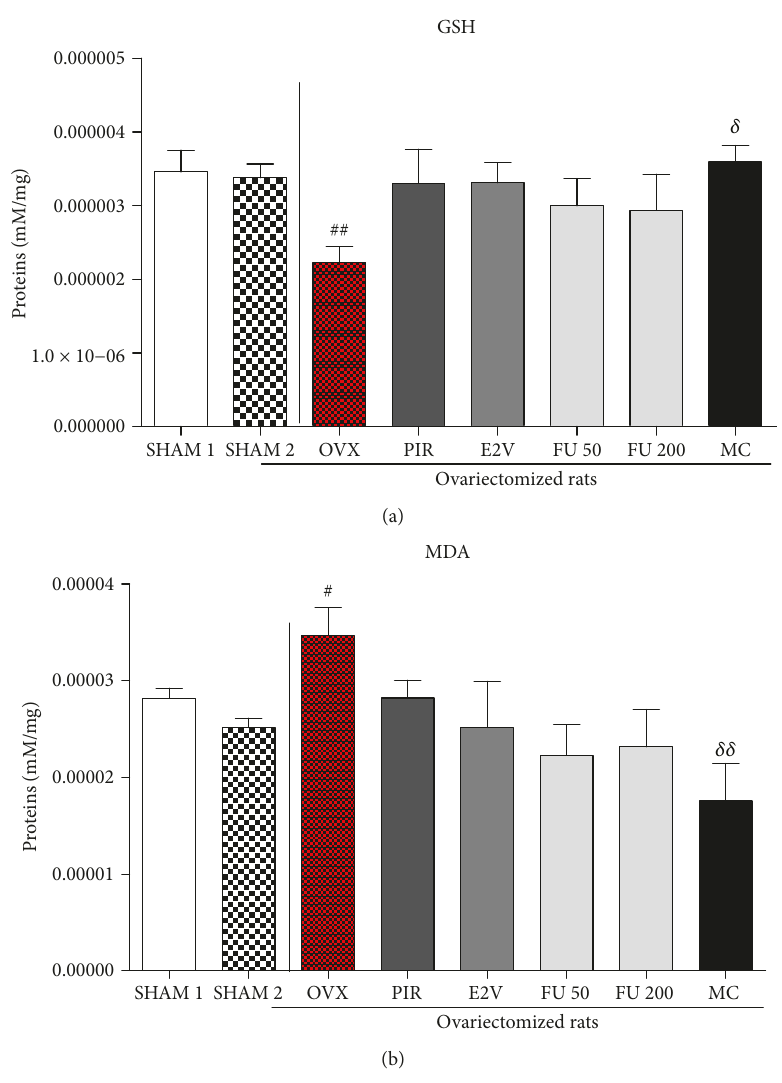
Figure 8: Reduction in glutathione-GSH (a) and malondialdehyde-MDA (b) after scopolamine exposition in rats treated with di ff erent substances. SHAM 1 =sham-operated rats treated with vehicle as normal control 1; SHAM 2=sham-operated rats treated with vehicle as normal control 2; OVX =ovariectomized rats treated with vehicle as negative control; PIR =ovariectomized rats treated with piracetam at the dose of 1.5mg/kg BW as positive control 1; E2V=ovariectomized rats treated with estradiol valerate at the dose of dose 1mg/kg BW as positive control 2; FU 50 and 200=ovariectomized rats treated with F. umbellata aqueous extract at the doses of 50 and 200mg/kg BW, respectively; MC=ovariectomized rats treated with 7-methoxycoumarin at the dose of 1mg/kg BW. # p < 0 05 as compared to SHAM 1; ## p < 0 01 as compared to the SHAM 2 group; δ p < 0 05 and δδ p < 0 01 as compared to the OVX